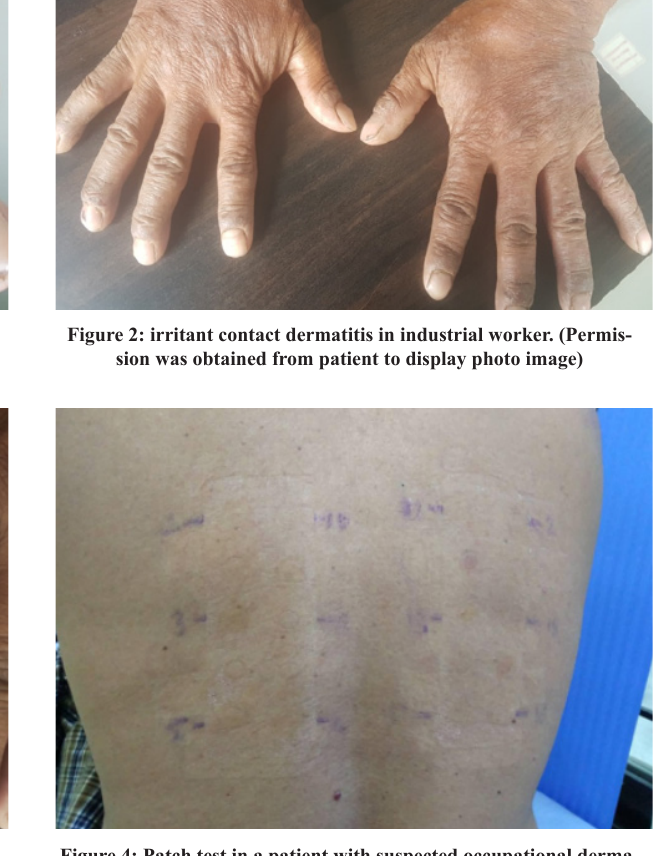
Figure 4: Patch test in a patient with suspected occupational derma- toses. (Permission was obtained from patient to display photo image)